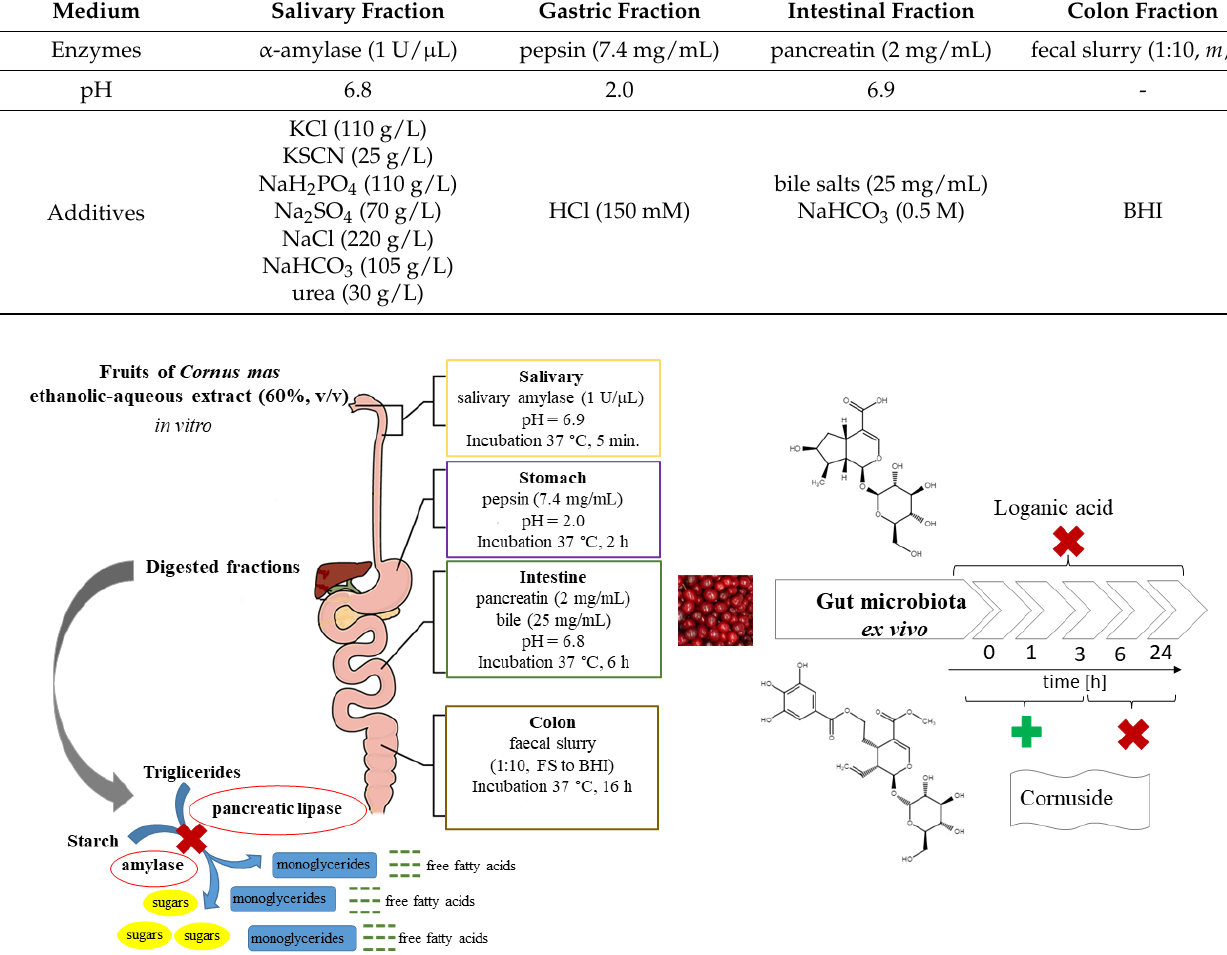
Figure 1. The scheme of the